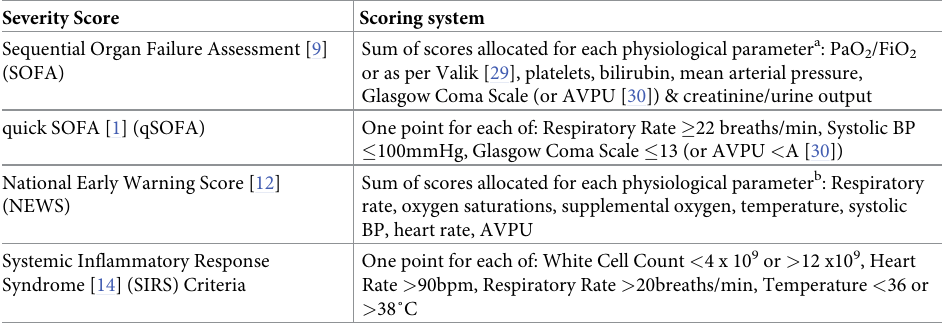
a Each parameter allocated a score of 0–4, detailed in S3 Table. b Each parameter allocated a score of 0–3, detailed in S4